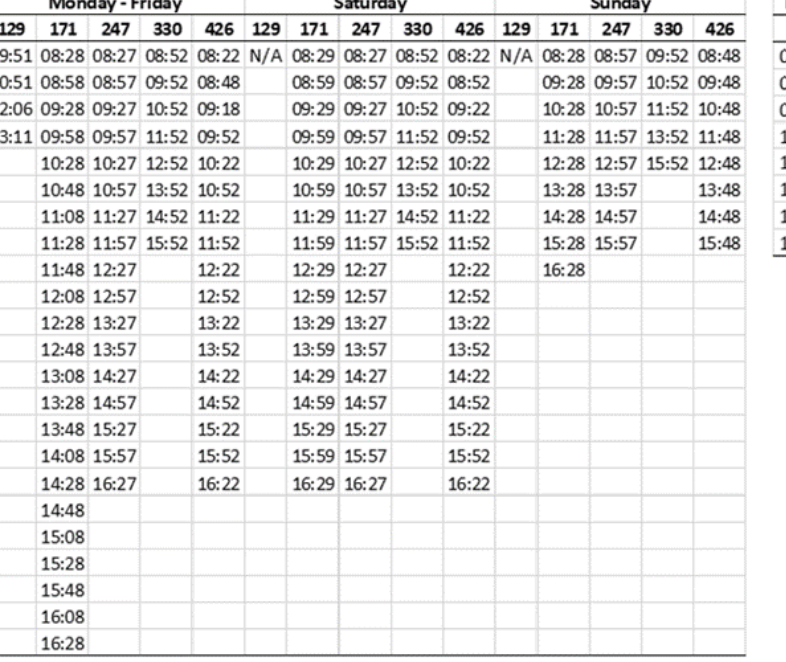
Figure 4. Examples of bus route schedules: Routes and departure times associated with a stop located in an inner city LSOA (Birchgrove, left ) and in a rural LSOA (Llan Festiniog, right ).